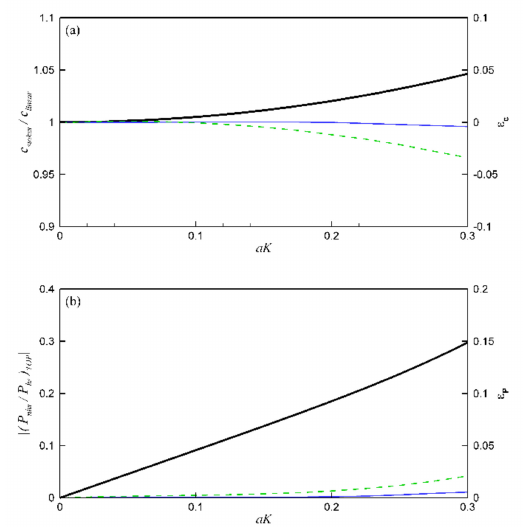
Figure 7. Sensitivity analysis of the physical and modeled non-hydrostatic e ff ects on the phase velocity of non-linear deep-water waves under di ff erent aK : ( a ) wave celerity and phase error ε c and ( b ) non-hydrostatic contribution and pressure error ε P at the top layer: analytical solution (bold solid lines), FNHS mode (solid lines), and QNHS mode (dashed